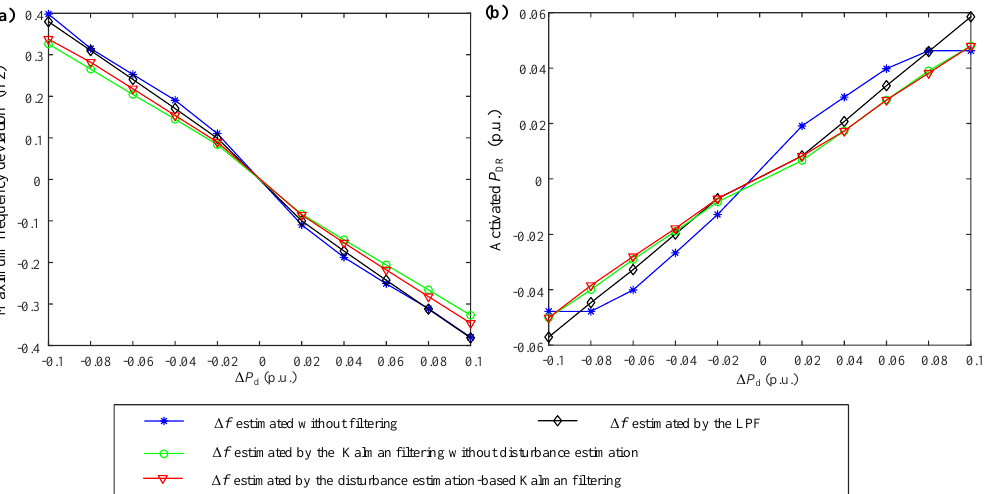
Figure 10. Maximum frequency deviation and maximum activat ed DR under different Δ P d values ( a ) Maximum frequency deviation. ( b ) Maximum activated DR appliances. ( a ) Maximum frequency deviation. ( b ) Maximum activated DR